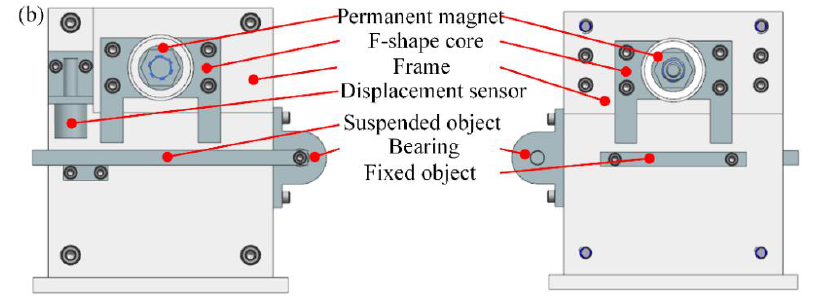
Figure 1. ( a ) Three-dimensional model of the proposed ZPPMSS-VFPC; ( b ) the structure of the suspension device.